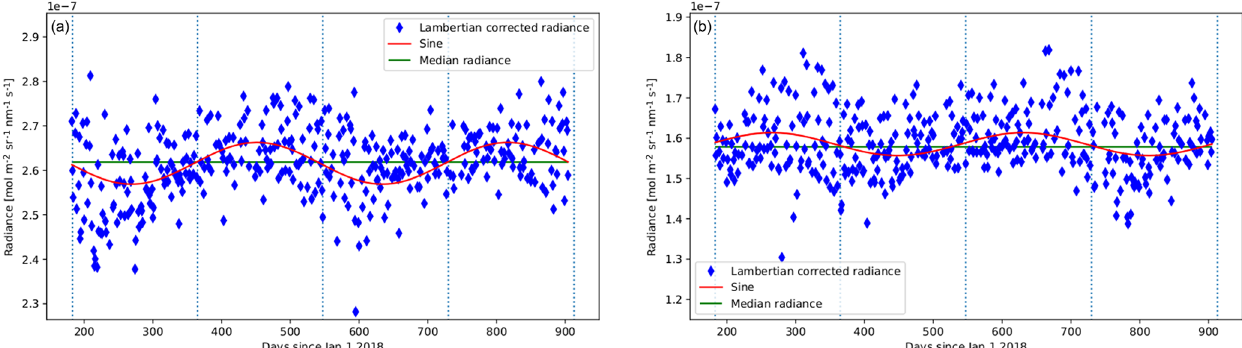
Figure 3. Continuum radiance of Libya3 (a) and NamibiaPICSAND1 (b) using a zenith angle filter of 50 ◦ without the yearly sine variation removed. Shown are all soundings over a period of more than 1000d, starting 28 April 2018. The median radiance (green) and a fitted sine (red) are shown. Data have been corrected for the solar zenith angle at each individual overpass and assuming the surface is Lambertian. Data of late 2019 are included to better illustrate fit. During this time, reliable cloud information has been